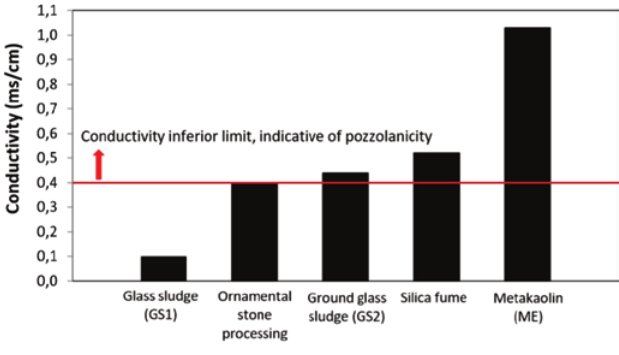
Pozzolanicity test as according to Luxán et al. [30] for the materials used in this study (GS1, GS2, ME) and other similar materials